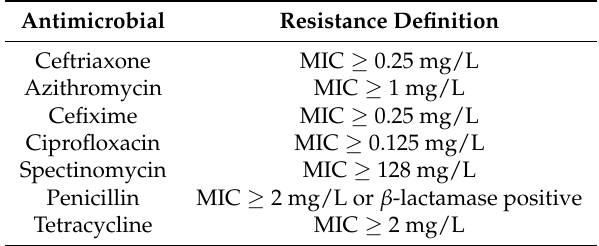
Table 1. EUCASTDefinitions of antimicrobial resistance.